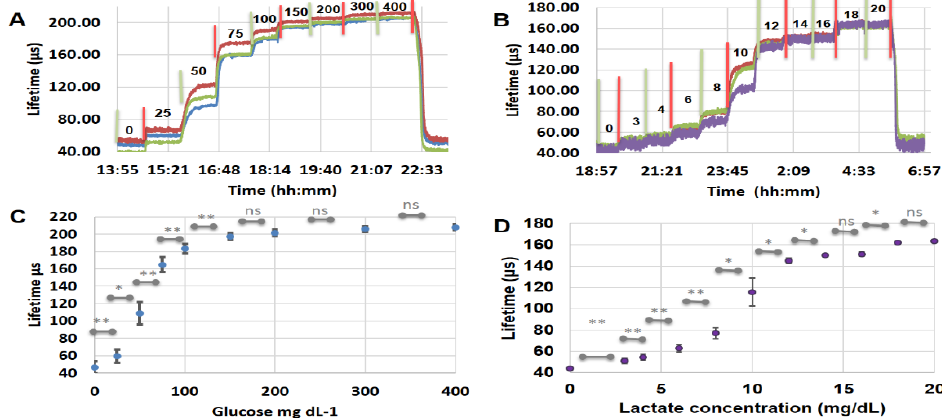
Figure 8. ( A ) Time ramp of glucose response from the hydrogel glucose sensors containing glucose sensitive microdomains, and EC-PF68 NPs, ( B ) The time ramp response of hydrogel lactate sensors with lactate-sensitive microdomains in the range of 0–20 mg dL − 1 lactate in TRIS buffer. ( C ) A plot of average lifetime of glucose sensors vs. glucose concentration from hydrogel glucose sensors (n = 4). ( D ) Plot of average lifetime of lactate sensors (n = 4) vs. lactate concentration. Each response curve in panels ( A ) and ( B ) represents 3 distinct sensors prepared under identical conditions.